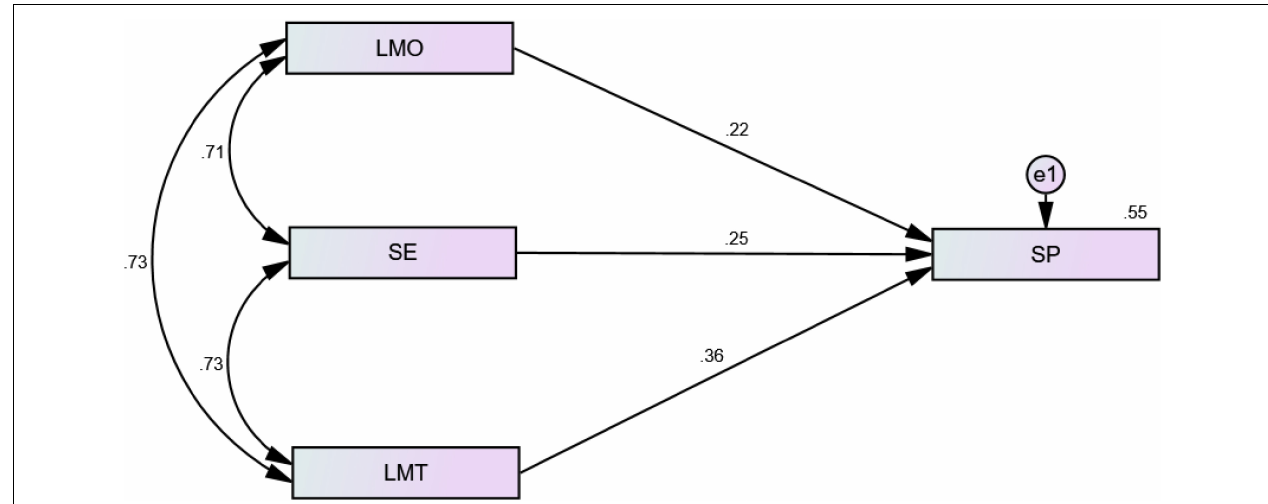
FIGURE 5 | Dimensional analysis of ML with